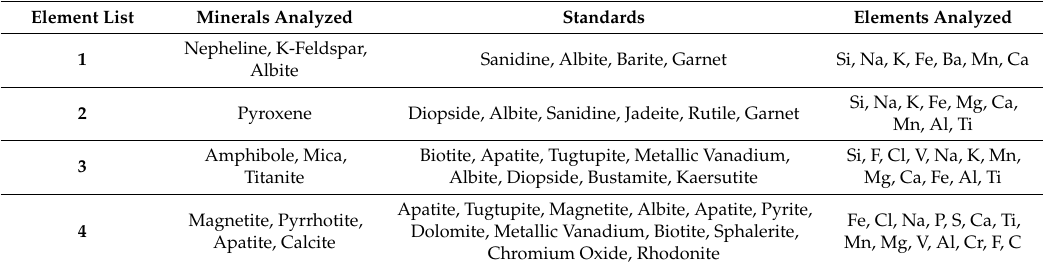
Table 1. Reference list for EPMA